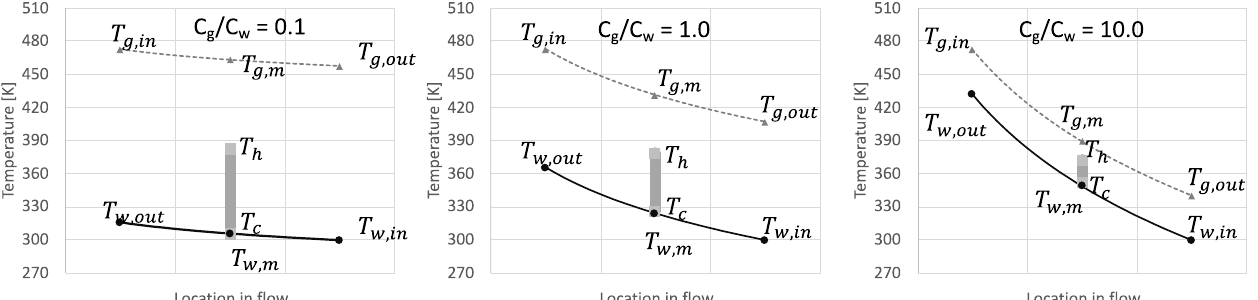
Figure 12. Temperature profile across the heat exchanger channels for the cases of C g /C w = 0.1, 1, and 10.